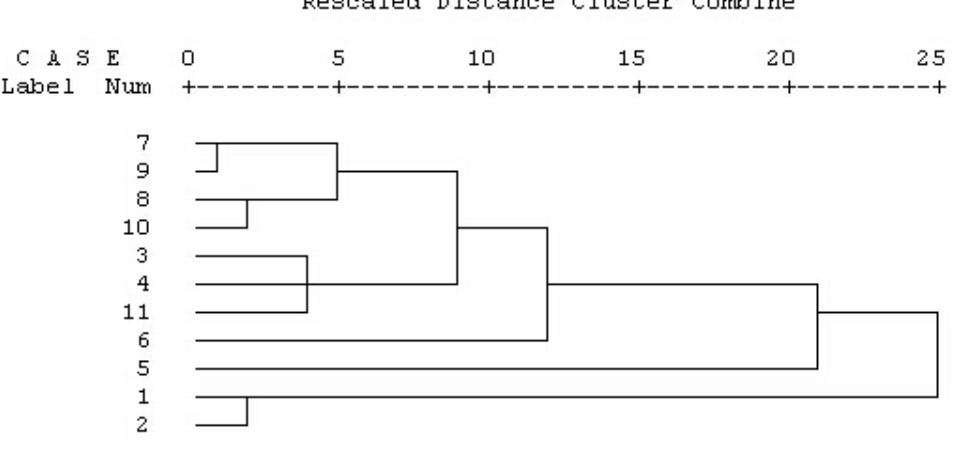
Figure 2. The results of HCA.